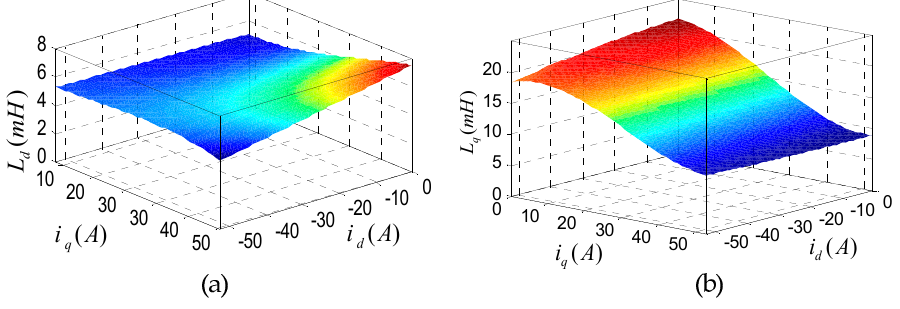
Figure 3. Nonlinear parameters. ( a ) d -axis inductance as function of dq -axis current; ( b ) q -axis inductance as function of dq -axis current.